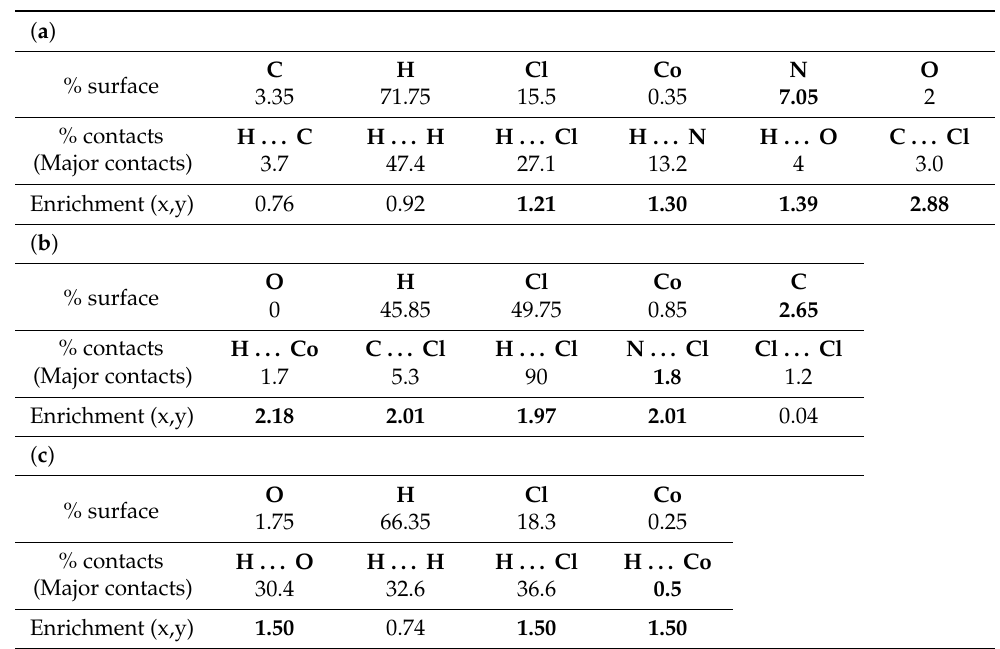
Table 7. Chemical proportions on the Hirshfeld surface and major interactions of the compound ( 2 ): ( a ) around the both organic cations, ( b ) around the [CoCl 4 ] 2 − and ( c ) around the water